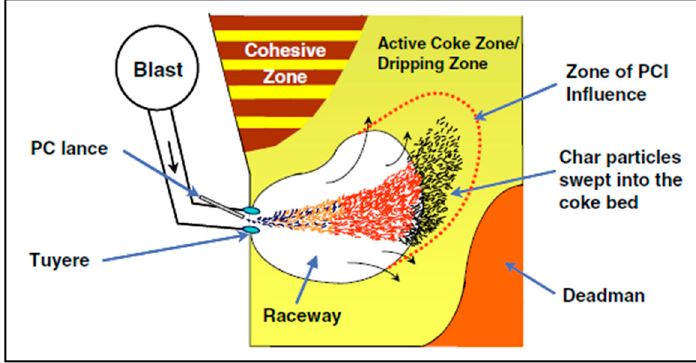
Figure 6. Schematic of the lower zone of the BF (adopted with permission from [96]).